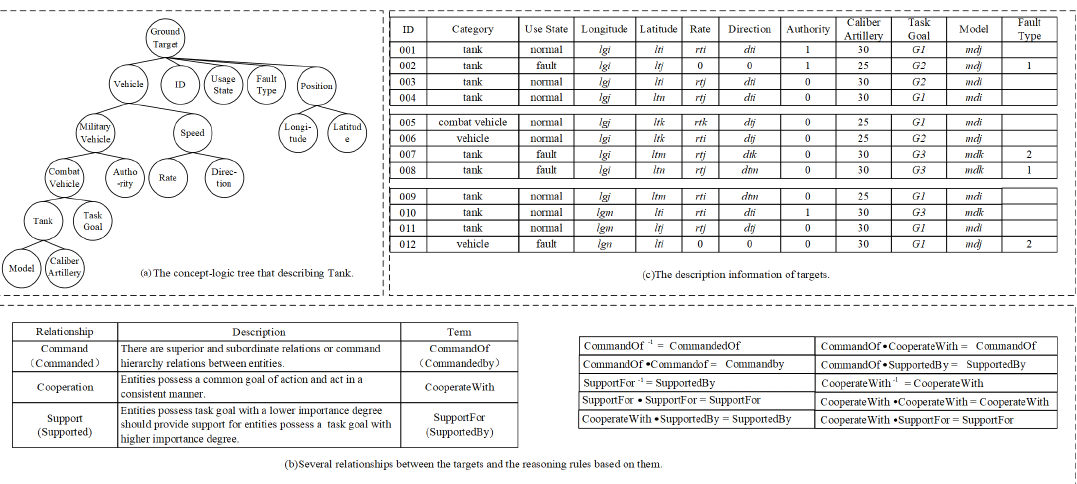
Figure 13. Information about targets, the concept-logic tree, and entity relationships used during the experiment.